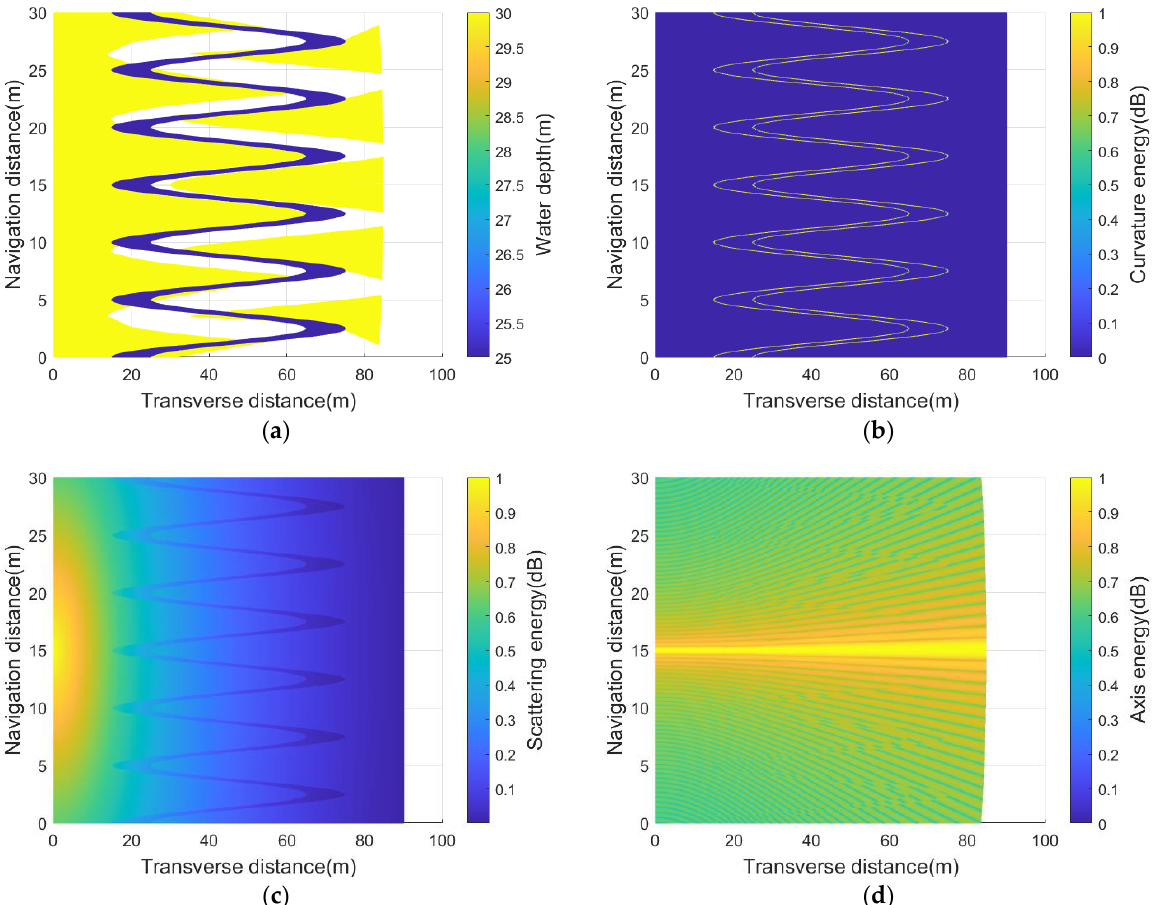
Figure 14. The receiving sensor ( θ − 3dB = 0.56 ◦ , f c = 400kHz) looks down 30 ◦ horizontally at (0,10,30) coordinate: ( a ) the virtual seabed simplified by shadow coefficient w shadow ( m ) ; ( b ) the curvature energy E curvature ( V ) ; ( c ) the scattering energy E scattering ( V ) ; ( d ) the acoustic axis energy E axis ( V ) . In addition, this form also sets weight coefficients w curvature , w scattering , w axis to balance each energy component. Figure 15 shows the simulation results for comparison